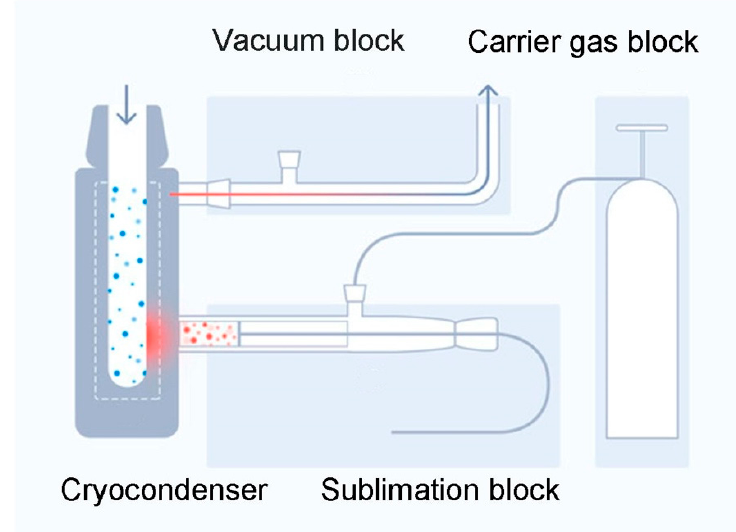
Figure 1. Nanostructure synthesis block-scheme (adapted from [44]).